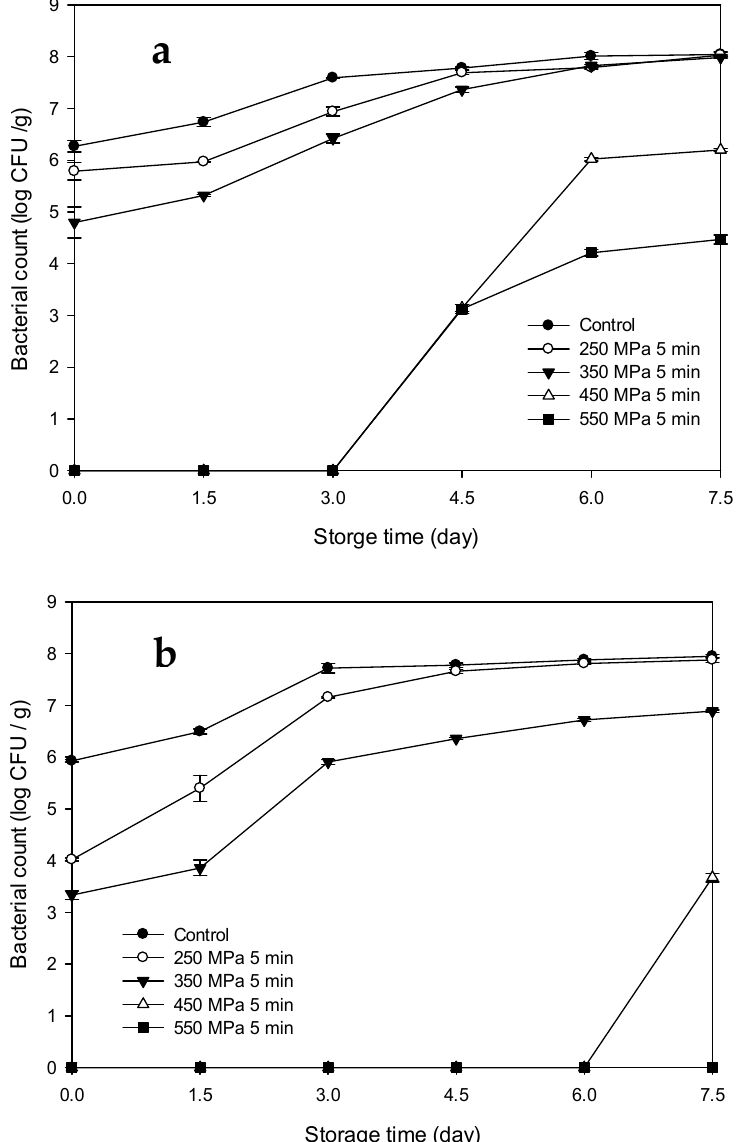
Figure 1. Changes in bacterial counts of tuna meat samples inoculated with ( a ) Morganella morganii and ( b ) Photobacterium phosphoreum after high-pressure processing treatment at 250, 350, 450, and 550 MPa for 5 min during storage at 15 ◦